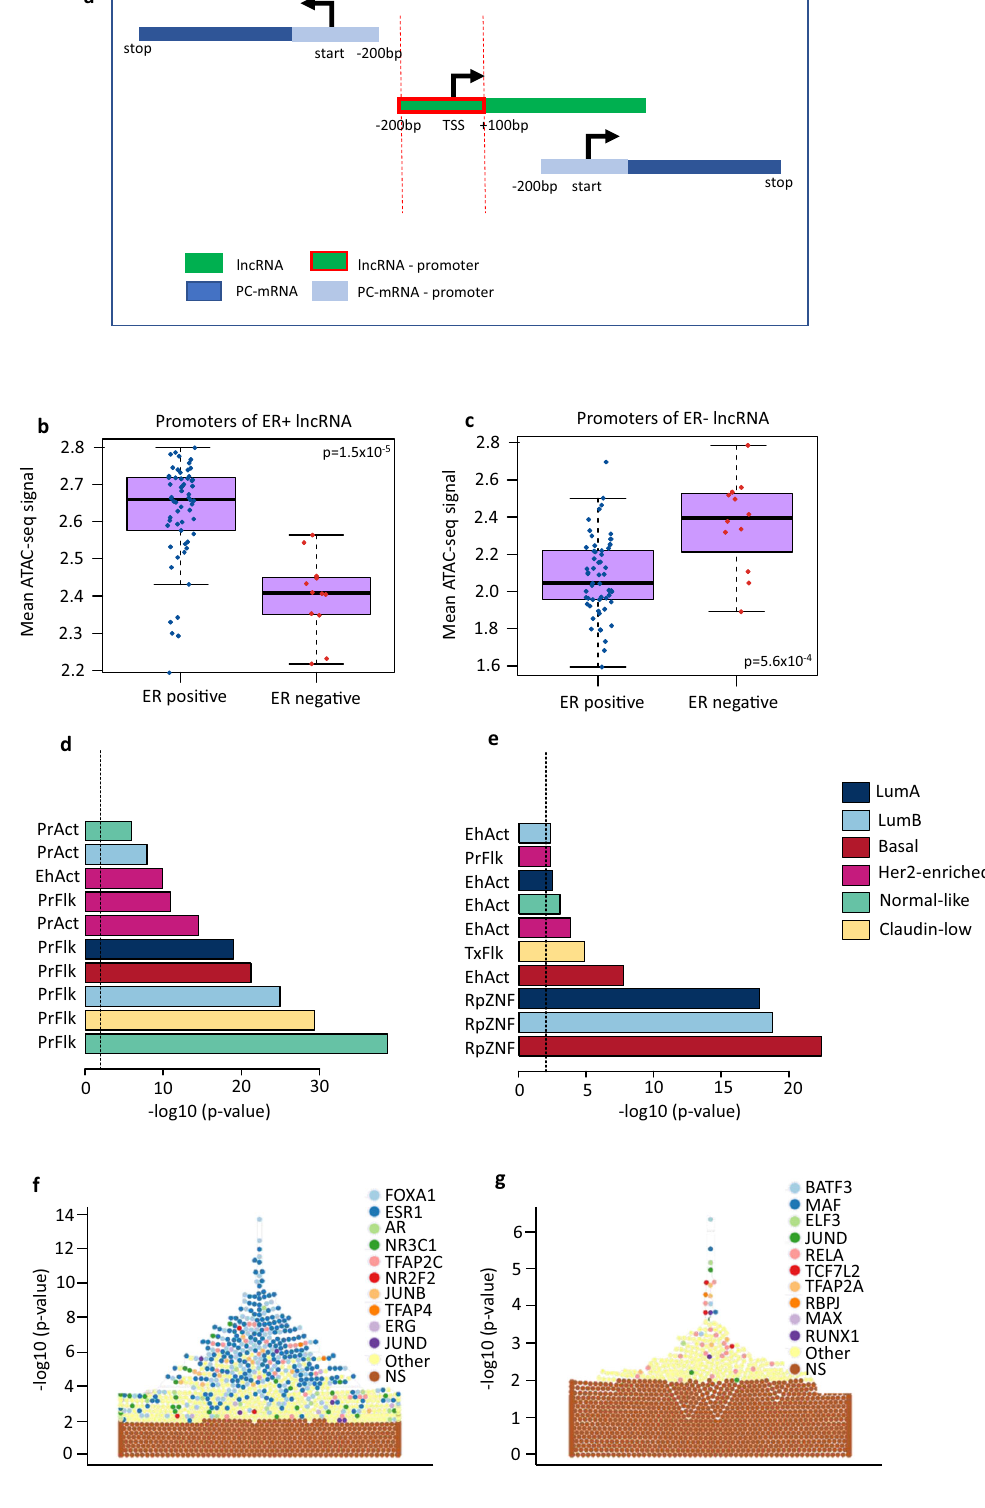
(Fig. 4f, Supplementary Data 6). On the other hand, promoters of the lncRNAs highly expressed in ER negative tumors were enri- ched for BATF3, MAF, and RELA, components of the NF- κ B TF complex, shown to be constitutively active in triple negative breast cancer 33 (Fig. 4g, Supplementary Data 6). To further assess the speci fi city of the TF binding according to length of the promoter chosen for the lncRNA, we assess three